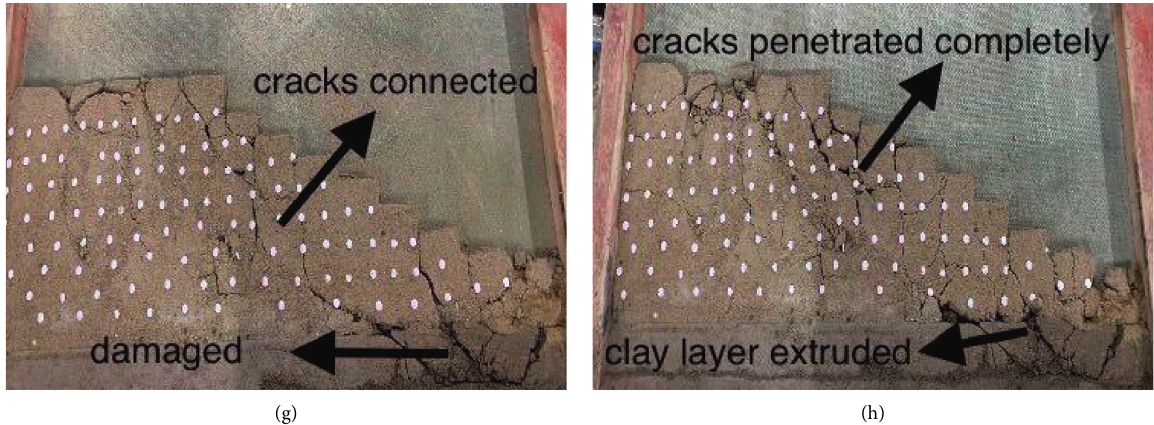
Figure 8: Destruction process of dumping yard. (a) 0.7s. (b) 1.3 s. (c) 2.7 s. (d) 4.8s. (e) 6.7s. (f) 8.6s. (g) 10.8s, (h) 13.9s.